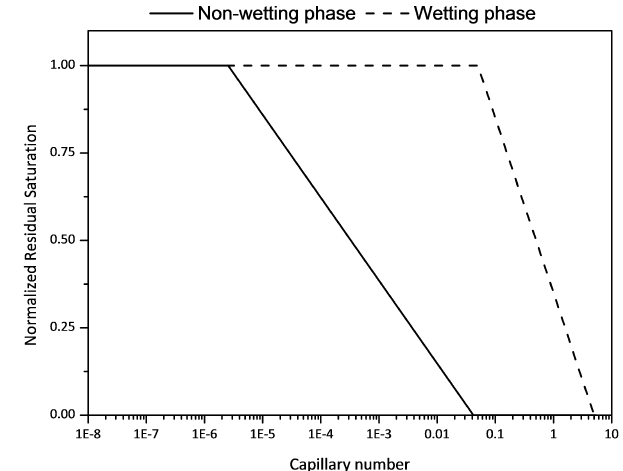
Figure 6. Capillary desaturation curves for non-wetting (oleous) and wetting (aqueous) phases used for this simulation